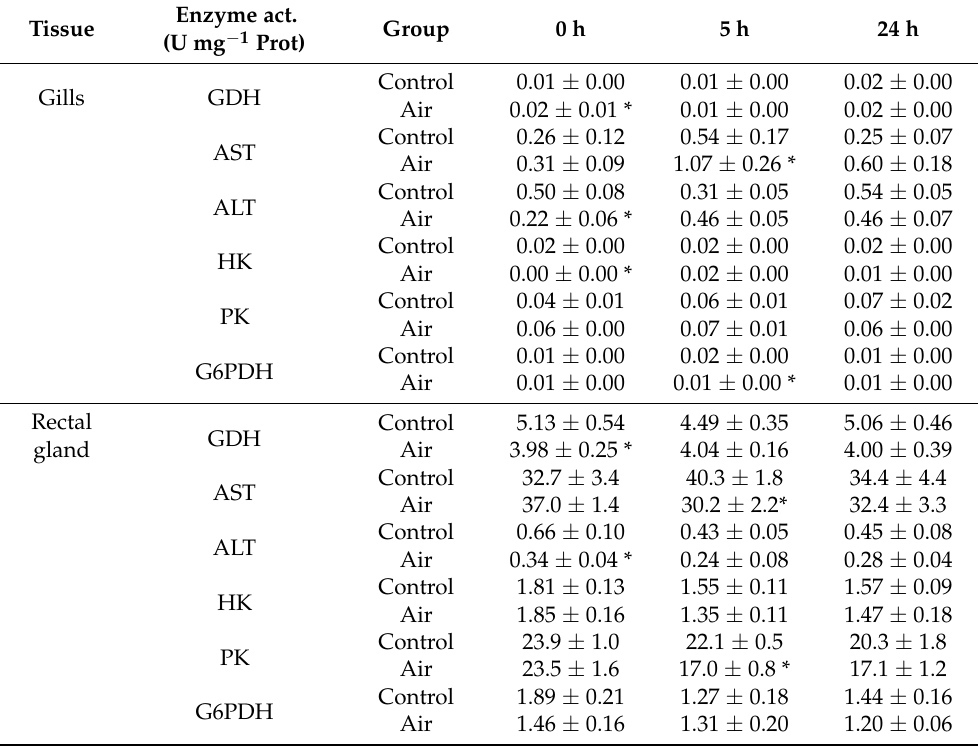
acid sequence alignments of slc9a1 from different vertebrate species. The transmembrane regions are shown in bold and underlined. Table 2. Activity of enzymes involved in the intermediary metabolism after air exposure in gills and rectal gland of S. canicula . Changes in amino acid turnover-related and glycolytic-related enzymes (hexokinase, HK; pyruvate kinase, PK; and glucose-6-phosphate dehydrogenase, G6PDH) activities (in U mg − 1 prot) in gills and rectal gland of S. canicula after air exposure. Data are expressed as mean ± s.e.m. Asterisks (*) indicate significant differences between both groups at each sampling time ( p < 0.05, n =